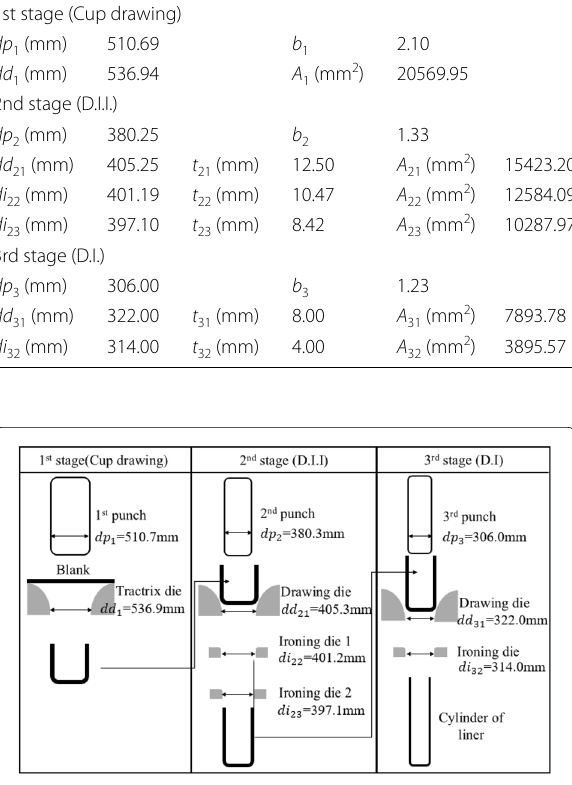
Figure 5 Dimensions of punches and dies calculated from the theoretical design rules of the D.D.I. process